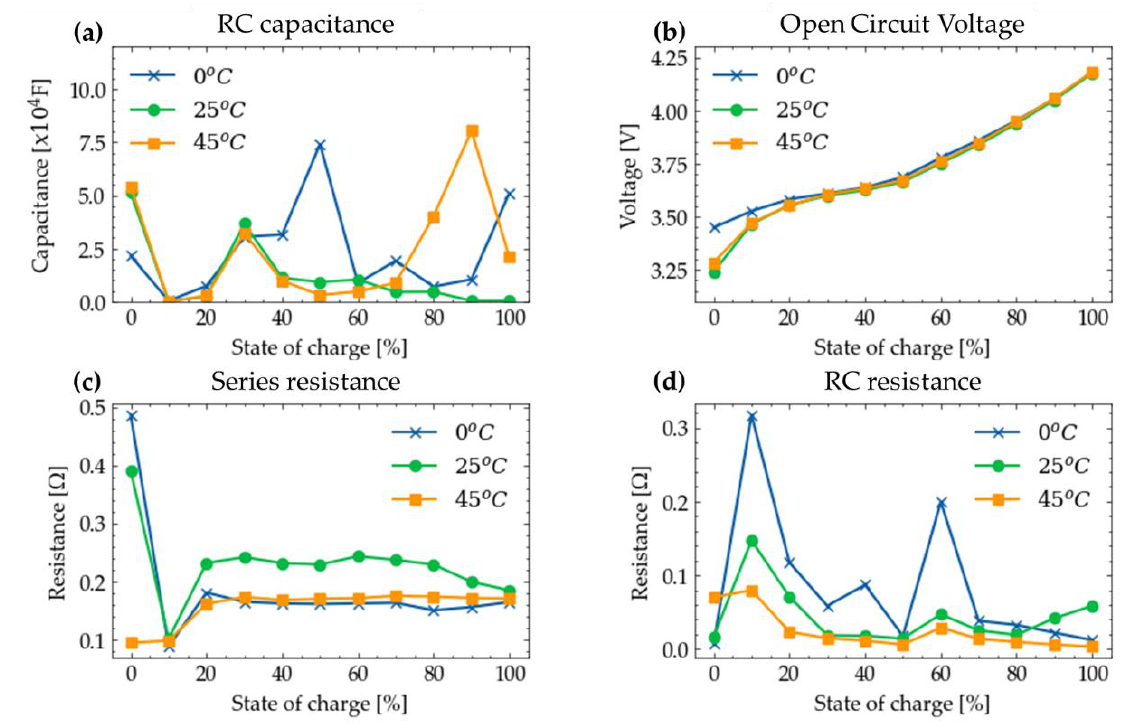
Figure 9. Two-dimensional look-up tables of Li-ion cell ECM parameters for a single number of RC branches, namely ( a ) RC capacitance, ( b ) open circuit voltage, ( c ) series resistance and ( d ) RC resistance.